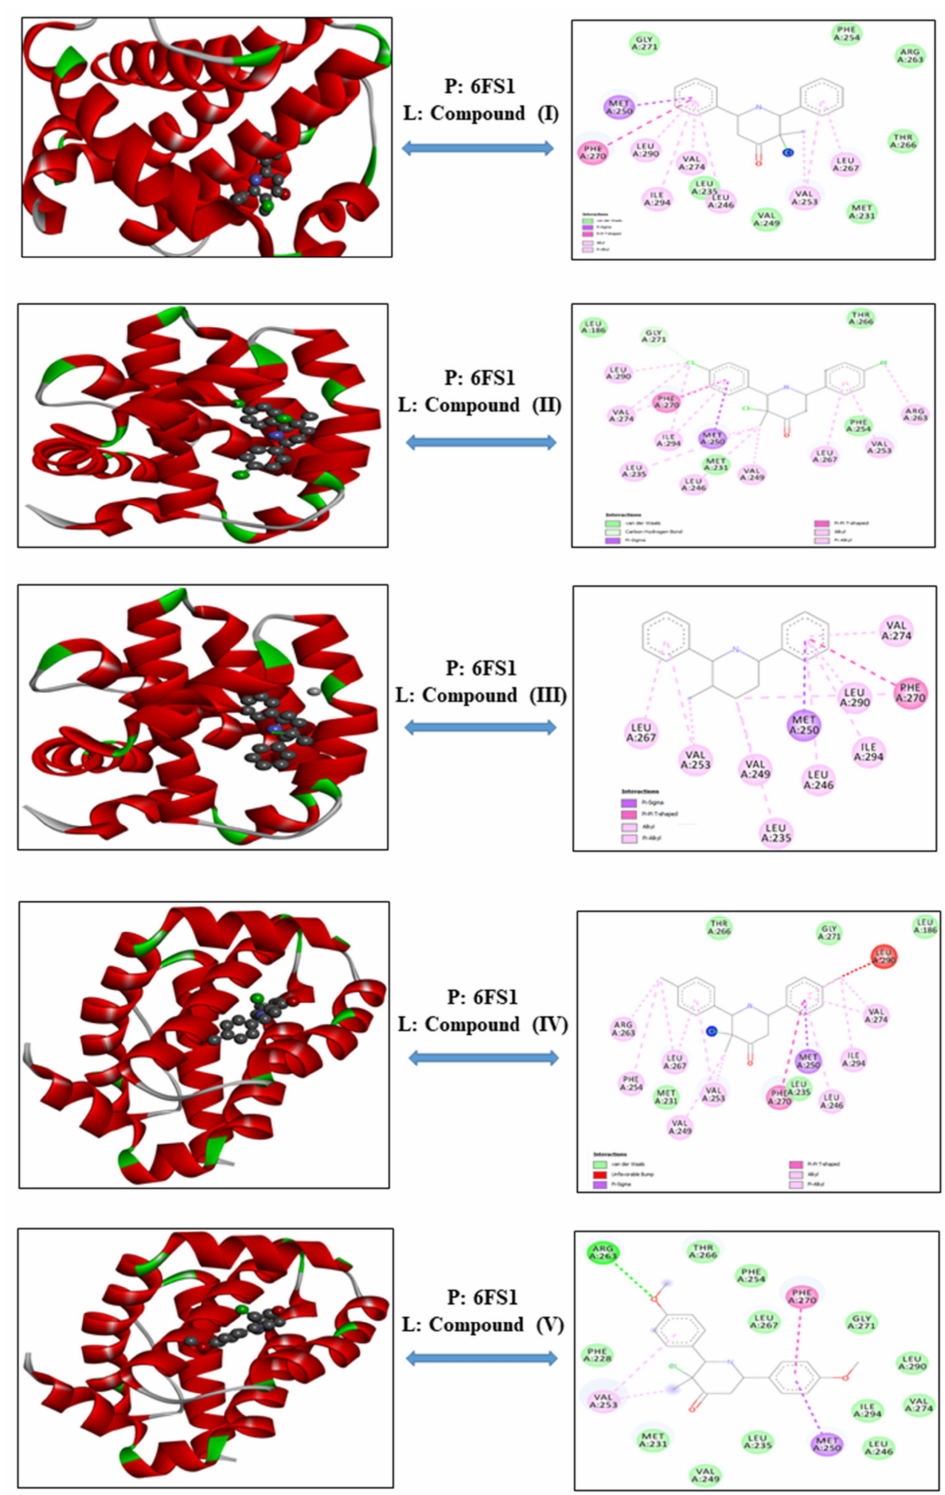
Figure 1. Compounds I – V (ligands) and 6FS1 (protein) are all best-docked positions, and the right side shows the lowest-energy 2D